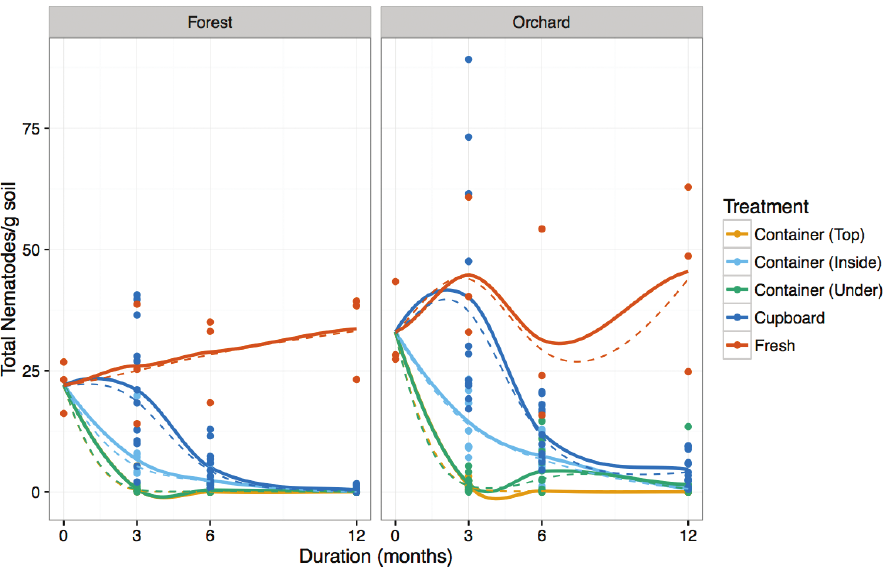
Figure 4. Scatterplot showing changes in mean total nematodes/ g soil at 0, 3, 6 and 12 months measured in soil recovered from on, in and under four sea containers and inside four cupboards. Solid lines show the smoothed means and dashed lines predictions from the preferred